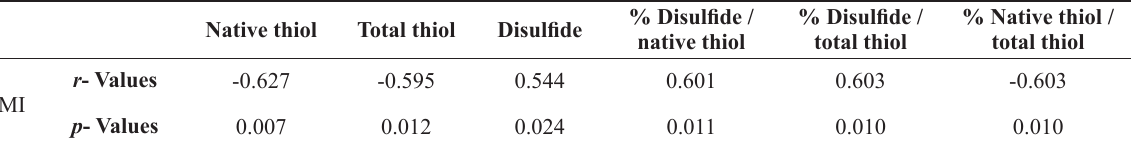
The relationship between BMI and TDH parameters in obese adults prior to the initiation of the exercise training